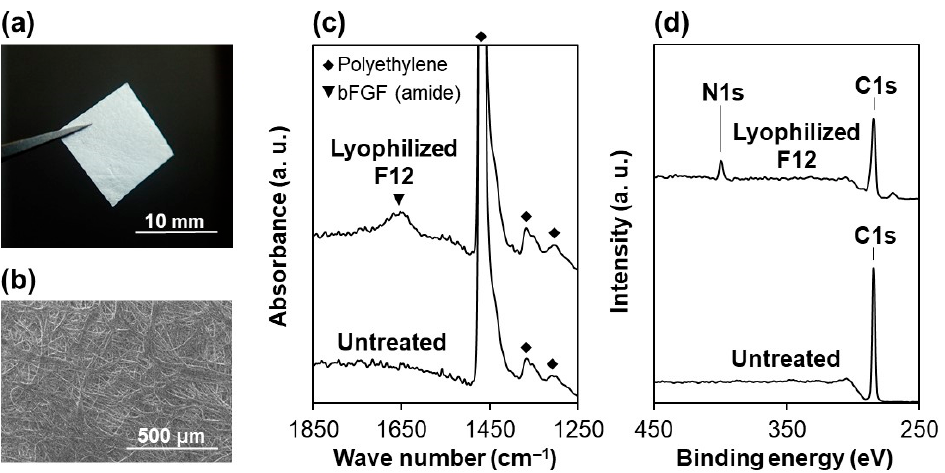
Figure 2. ( a ) Digital camera and ( b ) SEM images of the lyophilized F12 membrane, and ( c ) FT-IR spectra and ( d ) XPS spectra of the surfaces of the untreated and lyophilized F12 membranes.